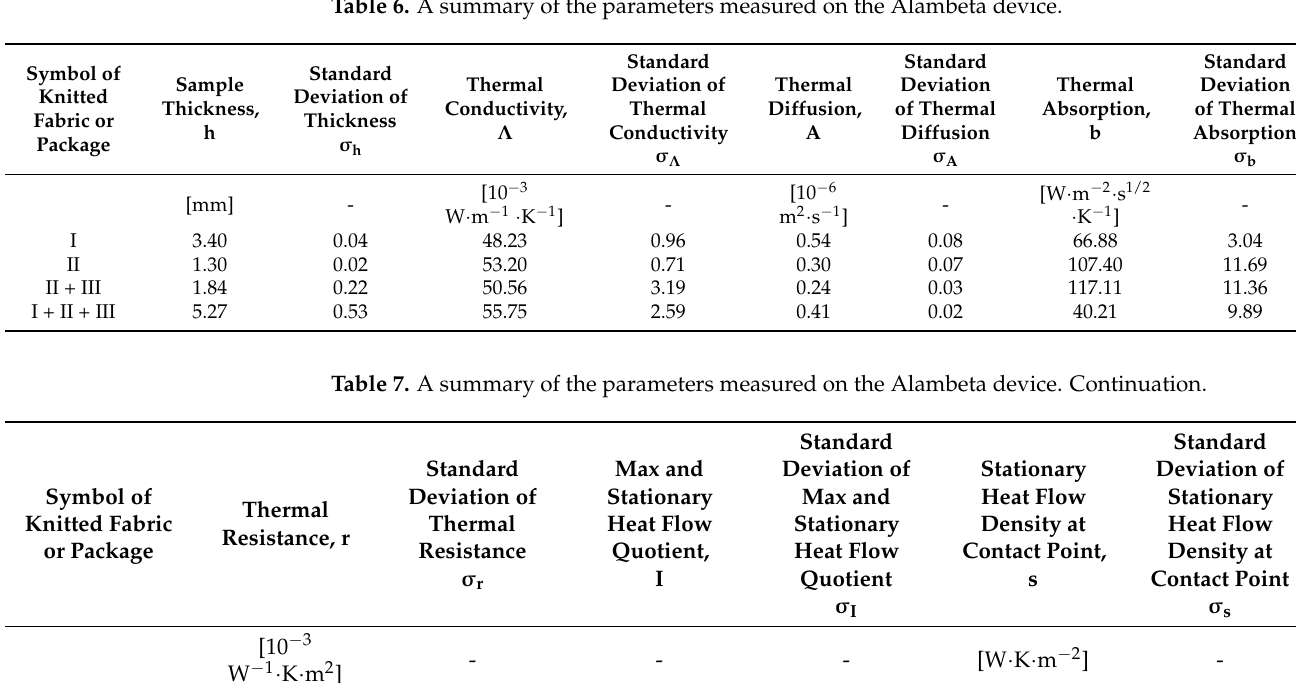
Table 6. A summary of the parameters measured on the Alambeta device.